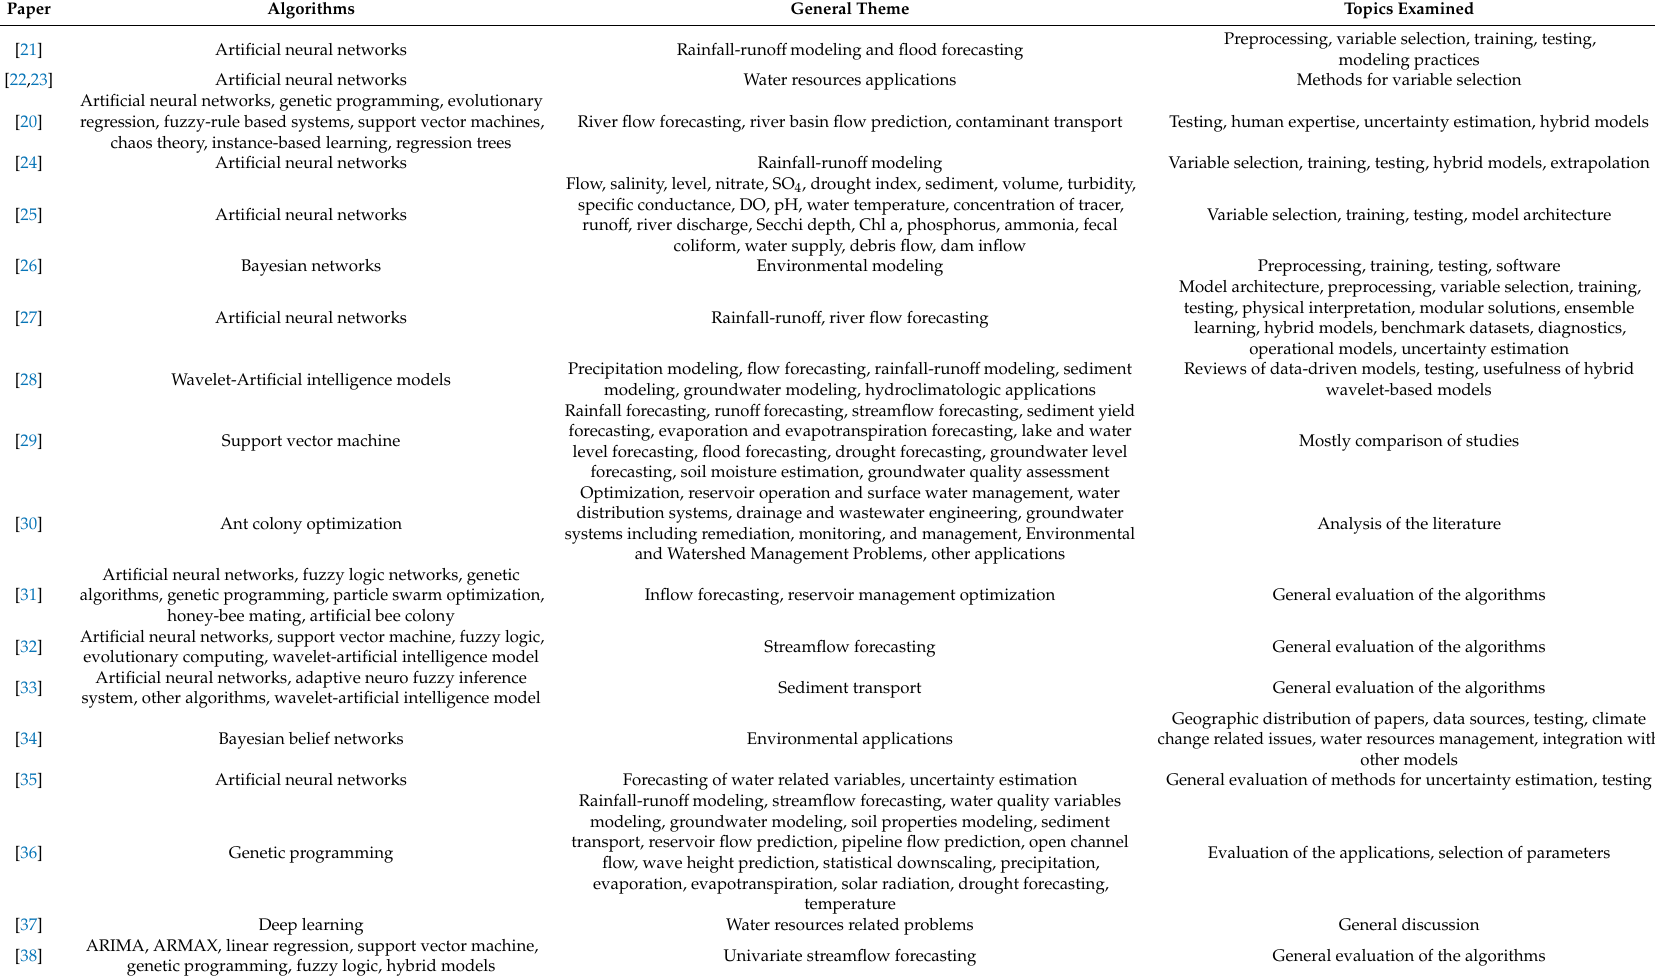
Table 1. Reviews of data-driven models in water